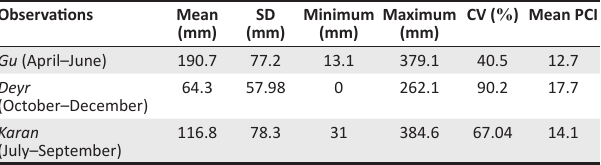
TABLE 6: Descriptive statistics of seasonal rainfall